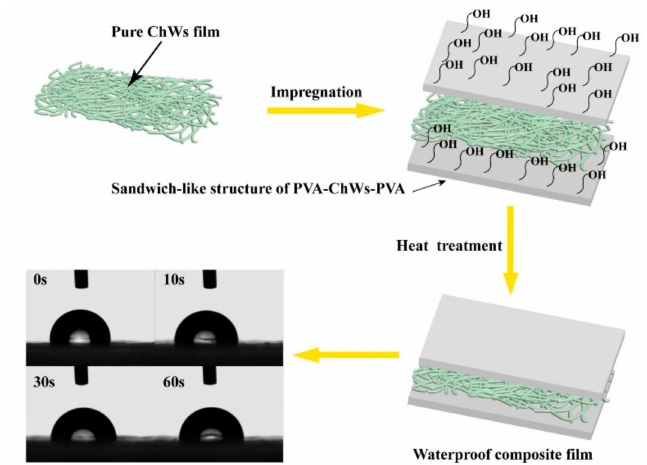
Figure 1. Flow chart of the preparation of PVA/ChWs composite film.